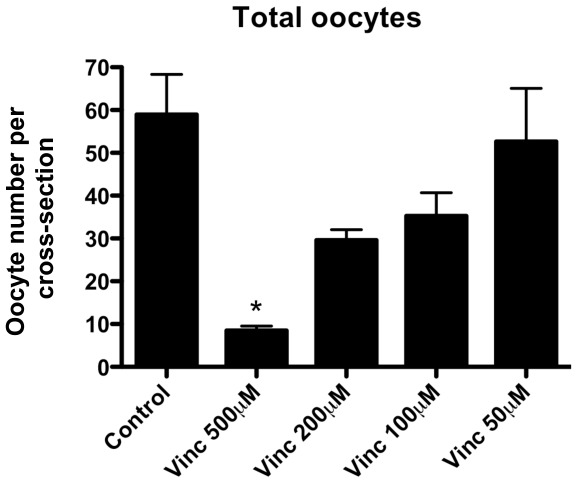
Number of oocytes per ovarian cross-section in ovaries taken from 4-day old rats and cultured whole for 10 days in the presence of different concentrations of vinclozolin.Data are from five different experiments performed in replicate. Asterisks indicate groups significantly (*p≤0.05) different than controls by ANOVA followed by Dunnet's post-hoc test.